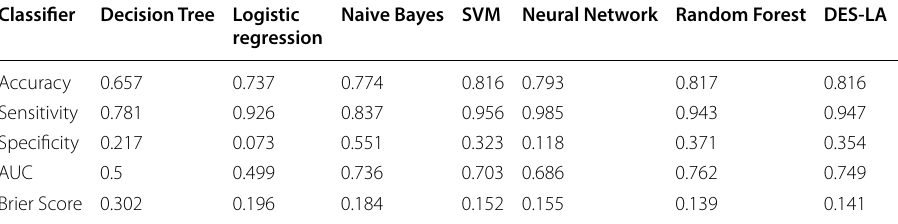
Table 6 Classifier performance without filtering on large default payments dataset Classifier Decision Tree Logistic Naive Bayes SVM Neural Network Random Forest DES‑LA regression